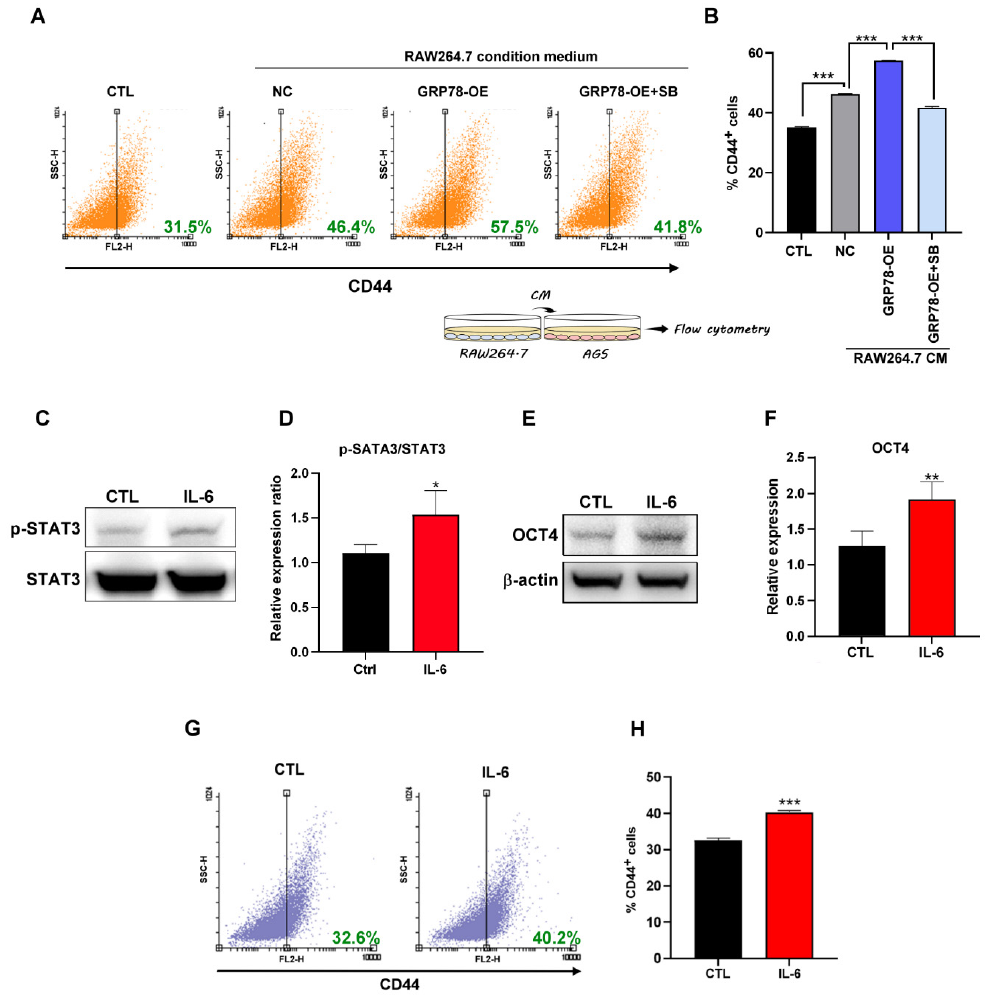
Figure 5. ( A , B ) Surface marker CD44 analyzed using flow cytometry in AGS after macrophage- conditioned medium treatment for 48 h. Data are presented as mean ± SEM for four independent experiments. Significance was calculated by one-way ANOVA analysis: *** p < 0.005. ( C , D ) p-STAT3 and STAT3 protein expression and quantification by Western blotting after treatment of AGS with 20 ng/mL IL-6 for 48 h. ( E , F ) OCT4 quantification by Western blotting after treatment of AGS with 20 ng/mL IL-6 for 48 h. ( G , H ) Surface marker CD44 analyzed using flow cytometry in AGS after treatment with 20 ng/mL IL-6 for 48 h. Data are presented as mean ± SEM for three independent experiments. Two-tailed Student’s t -test: * p < 0.05, ** p < 0.01 and *** p <